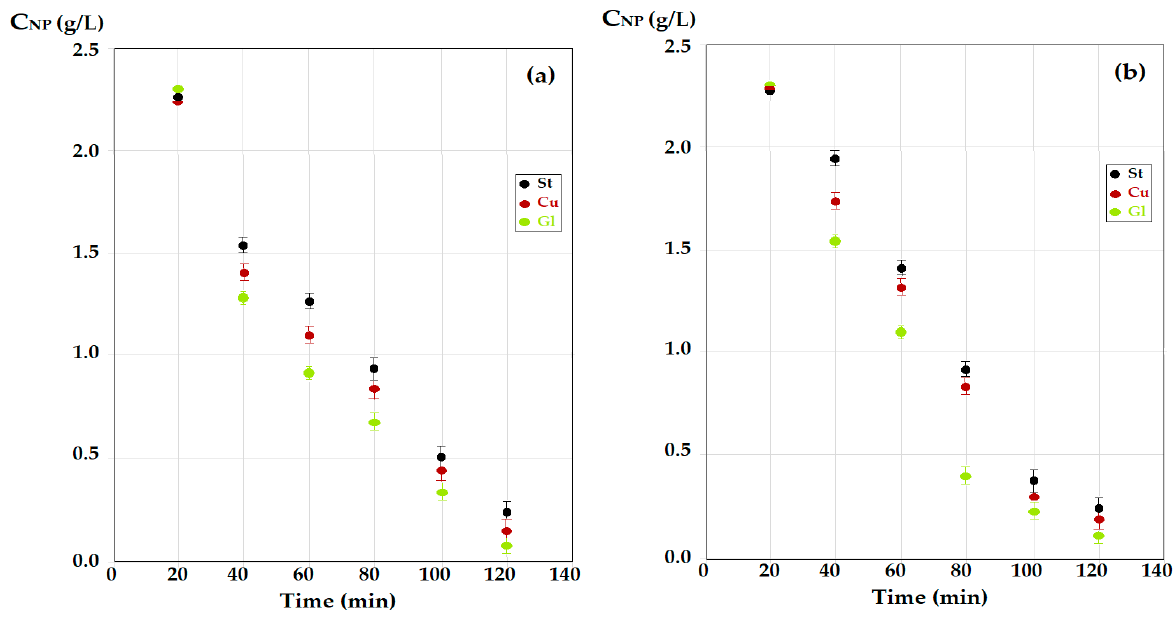
Figure 6. The decrease in concentration of p –nitrophenol for operation with the three types of materials: St, steel; Cu, copper; and Gl, glass; for the source phase with pH = 5 ( a ); and pH = 2 ( b ); at the same value of (pH = 13) of the receiving phase, for the n –decanol membrane.